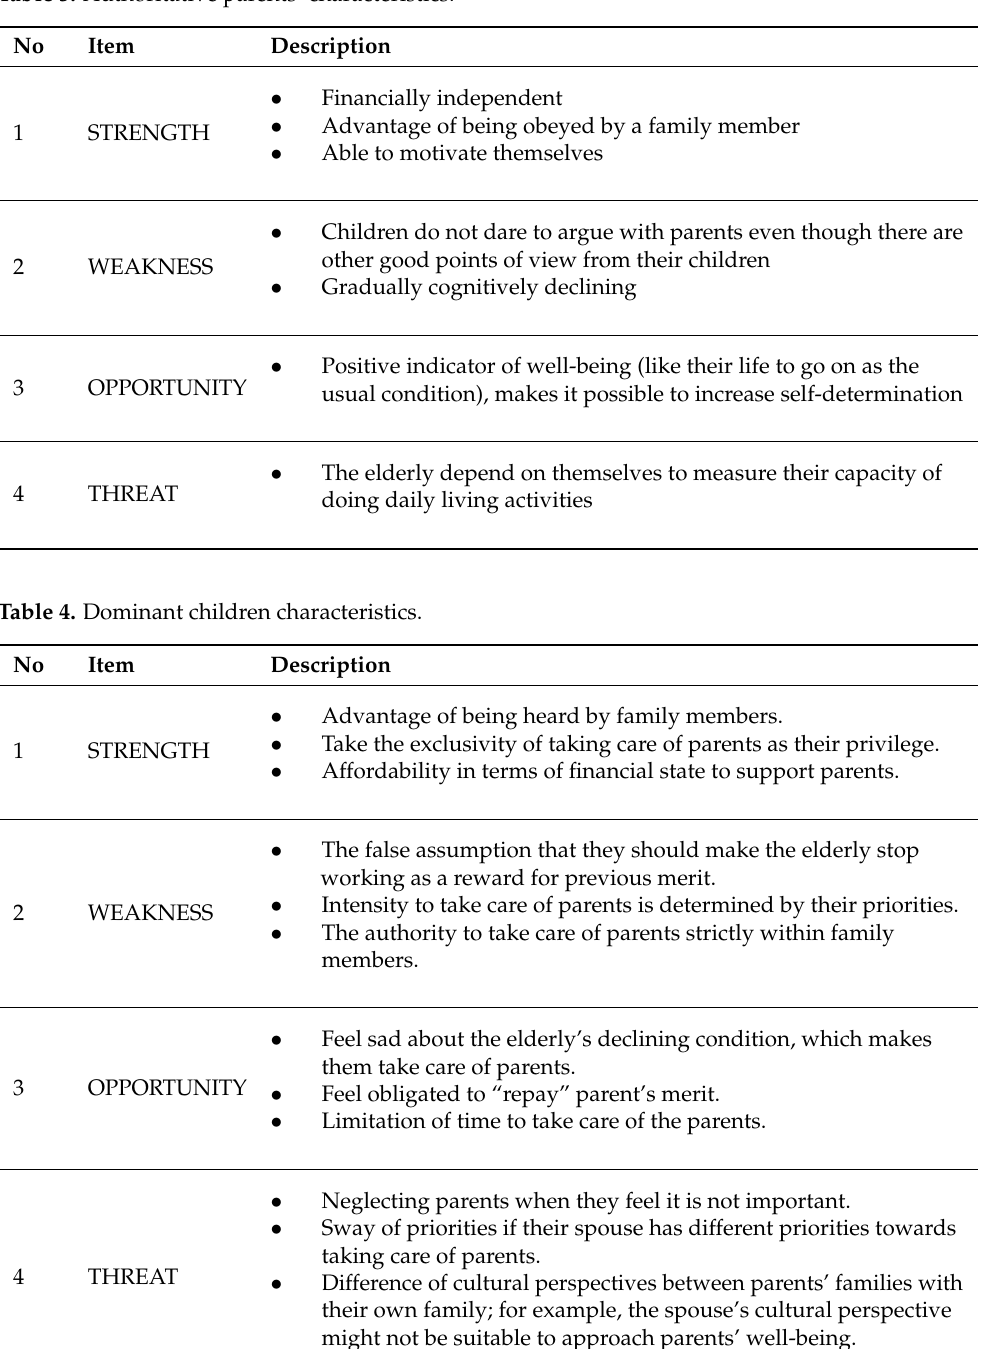
Table 3. Authoritative parents’ characteristics.